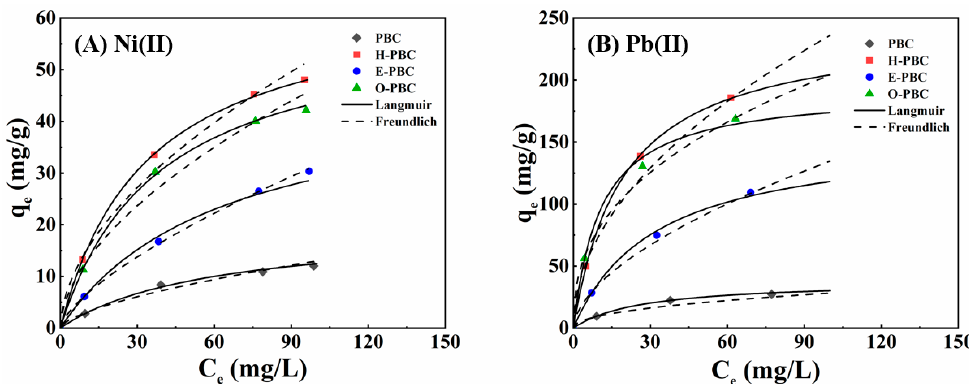
Figure 4. Sorption isotherms for ( A ) Ni(II) and ( B ) Pb(II) with PBC, H-PBC, E-PBC, and O-PBC.